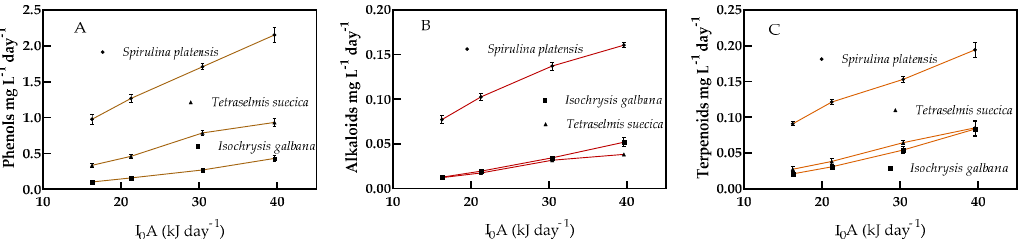
Figure 5. Phenols, alkaloids, and terpenoids productivities under continuous culture. ( A ) Phenols; ( B ) Alkaloids; ( C ) Terpenoids. At supplied light intensities (X axis) of 16.27, 21.26, 30.42, and 39.63 kJ d − 1 . Each point is the means of 3 replicates ( p < 0.05).